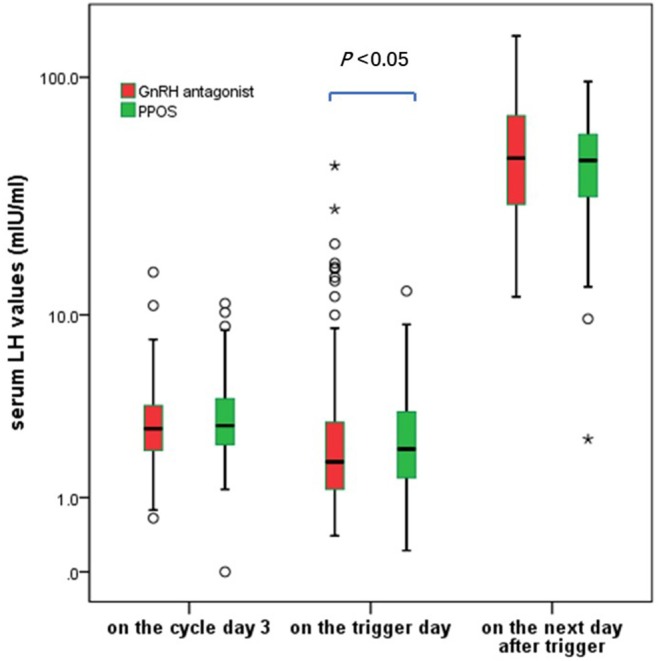
The serum LH fluctuation during the ovarian stimulation in the GnRH antagonist and PPOS groups. *In the boxplot represents the extreme points.